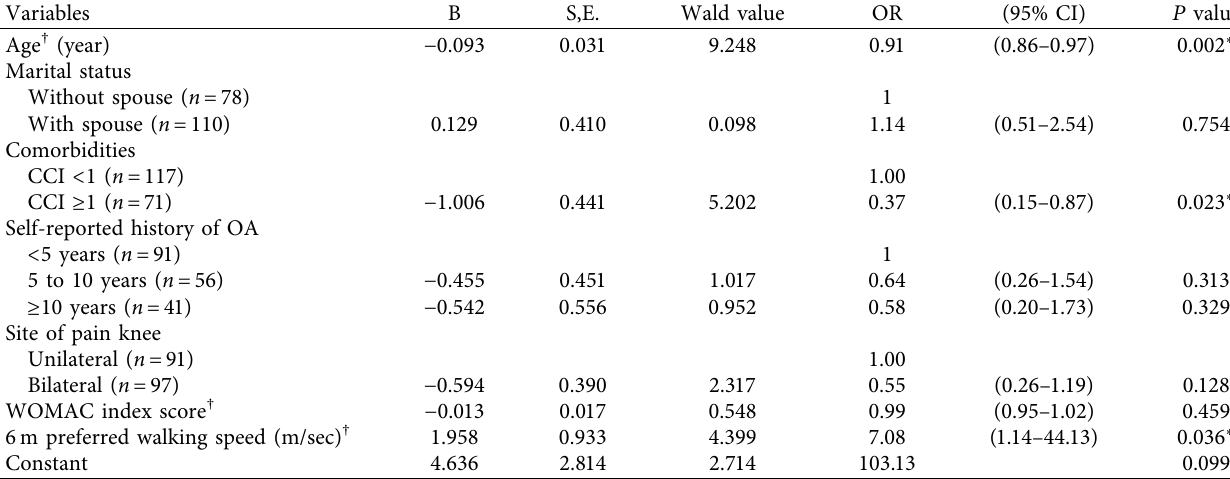
Table 3: Results of multiple logistic regressions analyses of active physical activities among people with KOA ( n � 188).